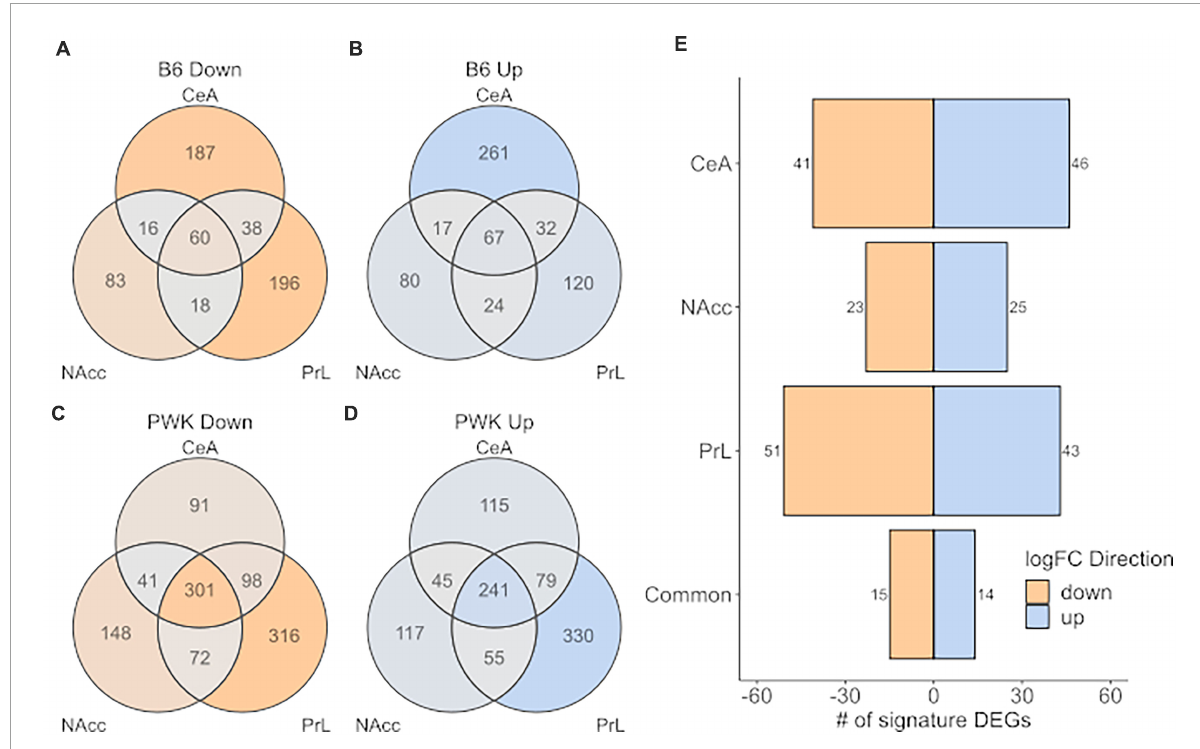
FIGURE5 High preference strains vs. low preference strains for unique DEG (strict selection criteria) commonality across strain and brain region. (A,B) Identified unique DEGs across individual brain regions for B6. (C,D) Identified unique DEGs across brain regions for PWK. (E) Unique DEGs commonly different between PWK and B6 compared to the low preference strains (AJ, CAST, NOD, NZO, S129, and WSB) for each brain region and in all three brain regions (common). Twenty-nine (15 down- and 14 up-expressed) unique DEGs are found to be commonly different between B6 and PWK and the low preference strains across all three brain